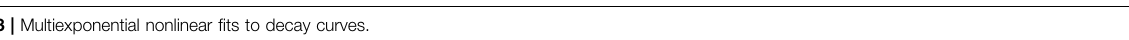
TABLE 3 | Multiexponential nonlinear fi ts to decay curves.